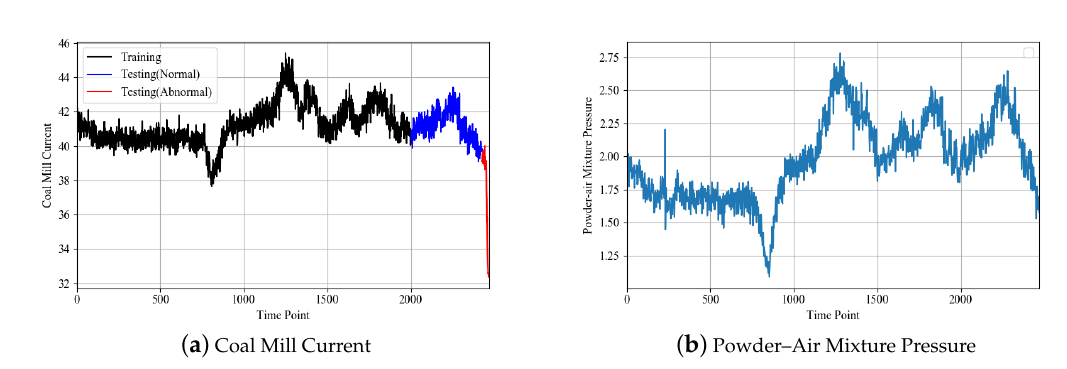
Figure 7. Schematic of features.